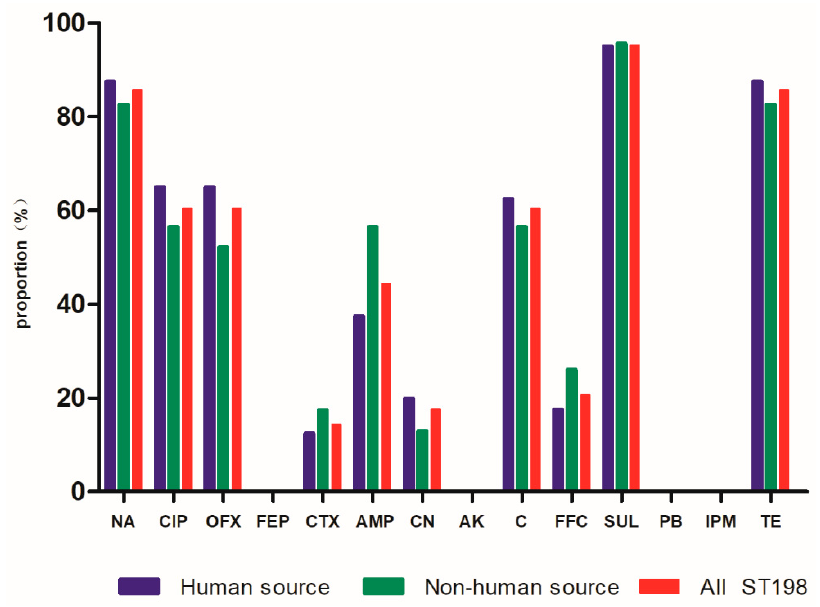
Figure 1. Drug resistance rate of 63 strains of Salmonella Kentucky ST198. Abbreviations: Penicillins: AMP (ampicillin); Quinolones: NA (nalidixic acid), CIP (ciprofloxacin), OFX (ofloxacin); Cephalosporins: